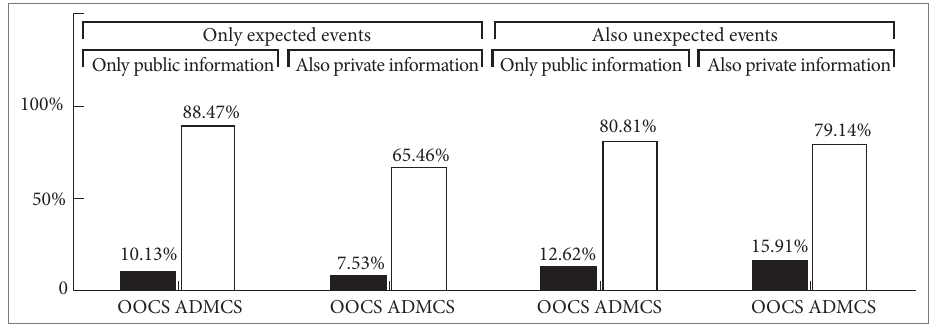
Fig. 8. Experiments with low agent switching costs, comparison between the OOCS-rule and the ADMCS-rule regarding the average deviations between the theoretic predictions and the experimental